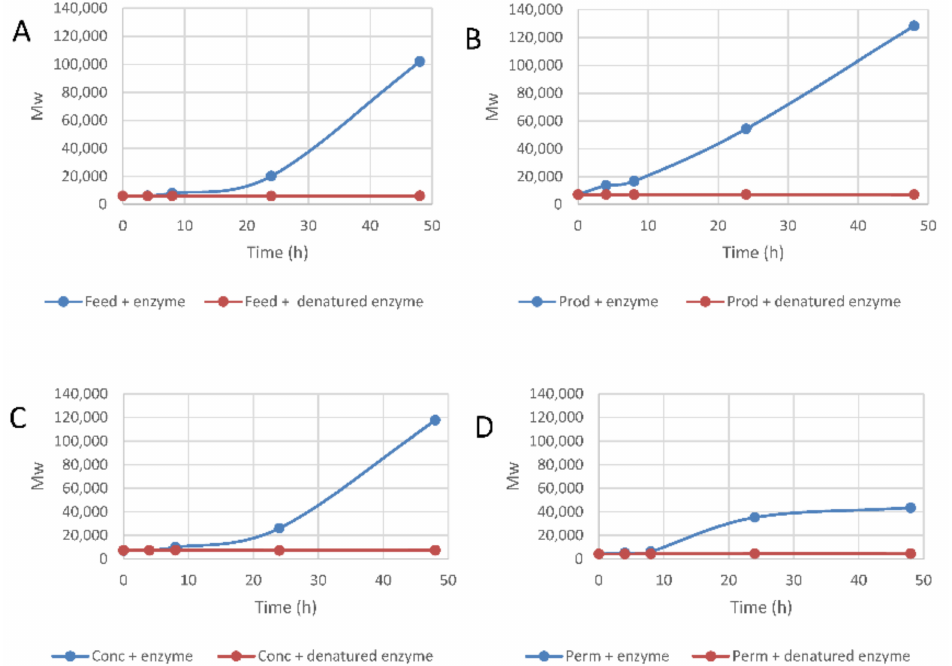
Figure 1. Plots showing M w (weight average molecular weight) values determined using GPC as a function of reaction time. The four lignosulfonate preparations included were ( A ) Feed , ( B ) Prod , ( C ) Conc , and ( D ) Perm . Reactions were performed with active (blue symbols) or denatured (red symbols) laccase. M w values represent poly(styrenesulfonate) equivalents determined using UV